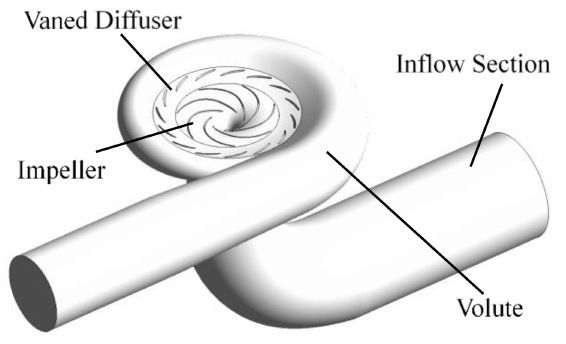
Figure 6. Flow domain of the pump